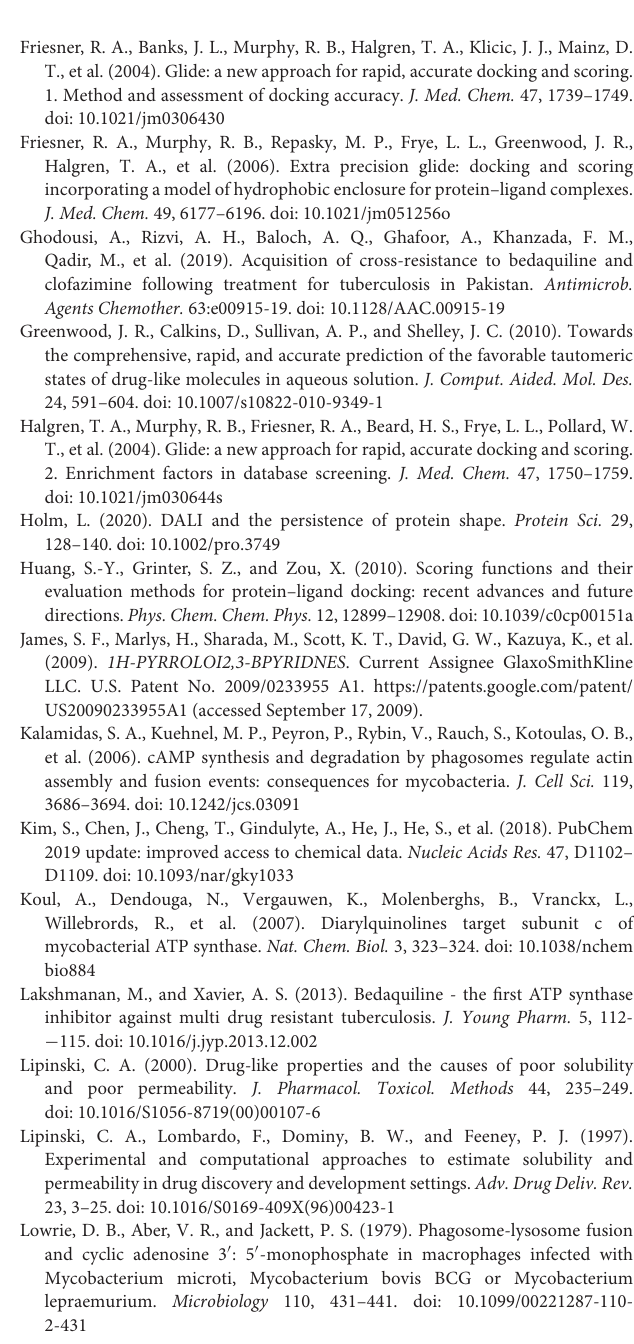
Supplementary Table 1 | EDIA report for cAMP and the binding site residues in chain C of 5AHW.